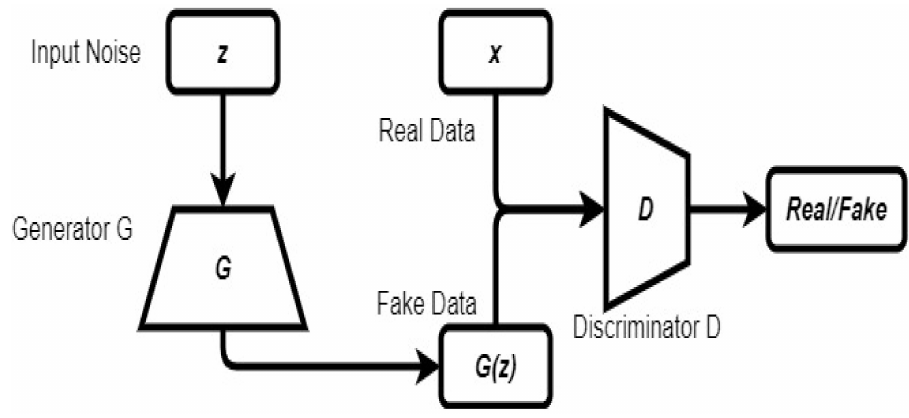
Figure 6. Architecture of a generative adversarial network (GAN) (adopted from [42]).